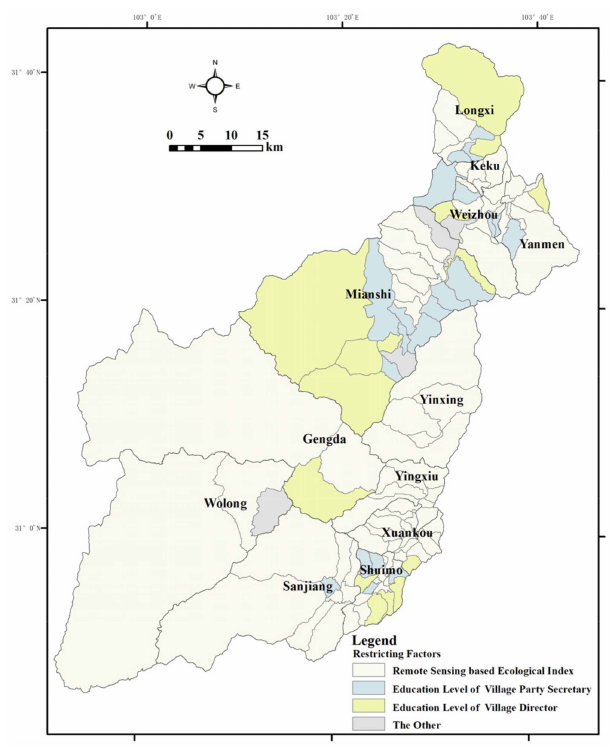
Figure 5. The spatial distribution of villages with three restrictive factors of IERSE in Wenchuan County.